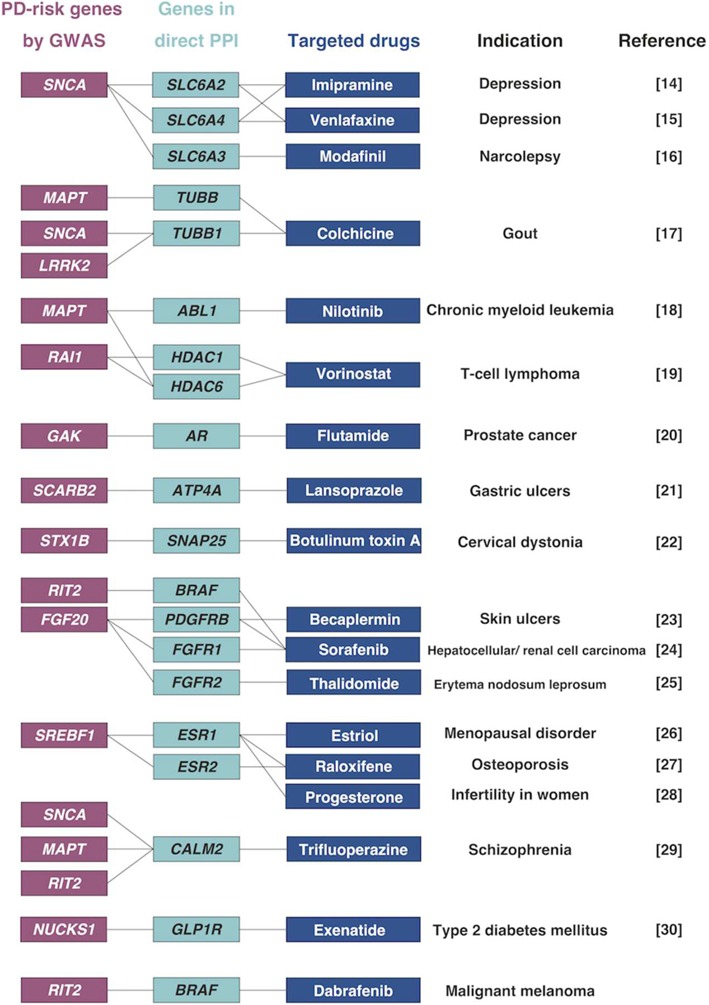
Examples of candidate drugs for PD identified by in silico drug screening‘PD-risk genes’ were listed from the data of meta-GWAS for PD, and ‘genes in direct PPI’ were extracted using PPI databases. Using drug databases, we identified FDA-approved drugs that targeted ‘PD-risk genes’ or ‘genes in direct PPI’. These drugs are all approved for other diseases, and have already been reported as being neuroprotective for PD. We found dabrafenib as a new candidate drug for PD.